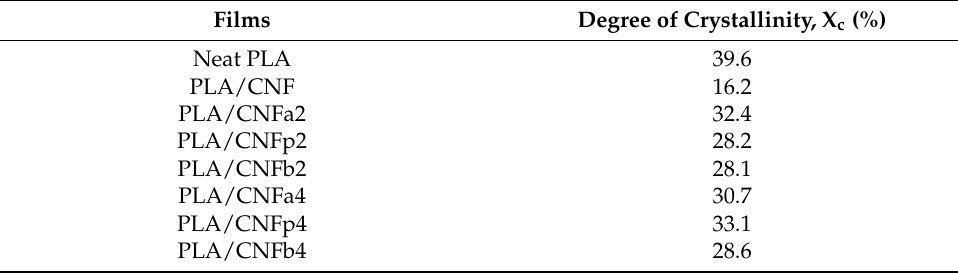
Table 5. The degree of crystallinity for PLA/m-CNF composite